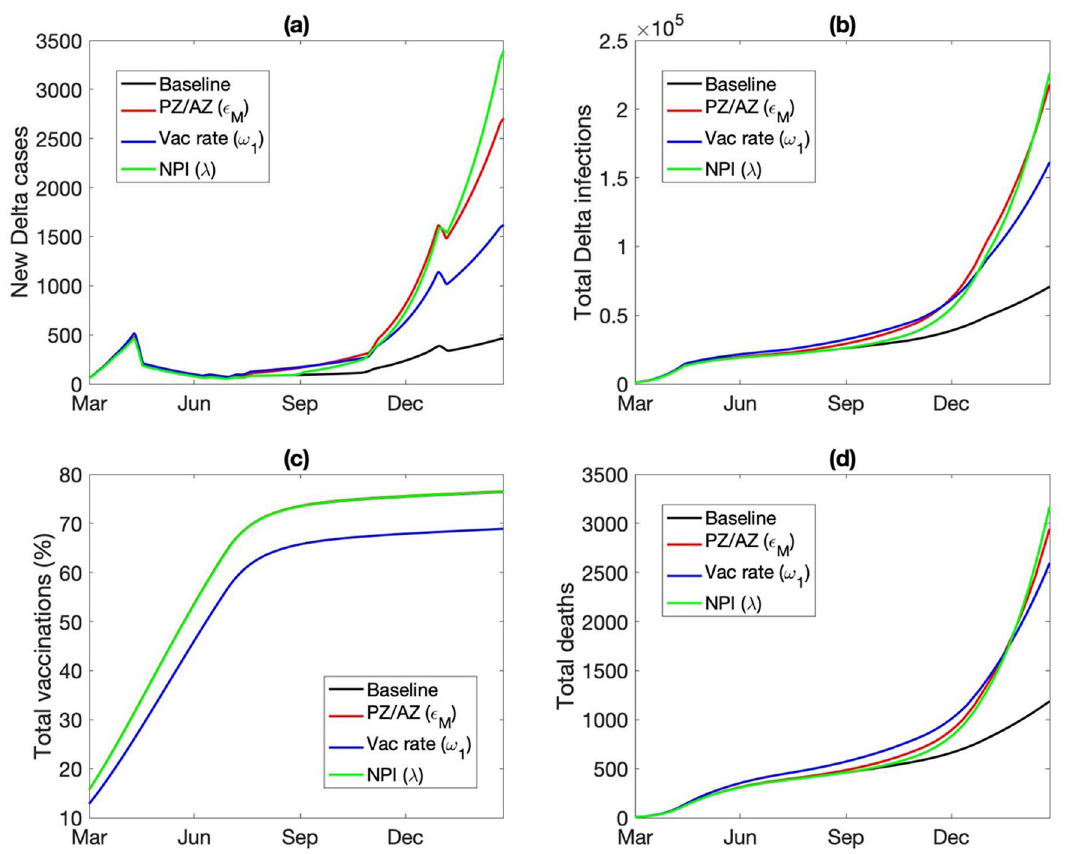
Figure 7. Predicted spread of the Delta variant, from March 2021 to March 2022, obtained for baseline parameters and three alternative scenarios. “PZ/AZ,” lower fraction of vaccines being Pfizer (from 95 to 40%), with the reduction made up with AstraZeneca, which offers reduced protection from Delta infections and a longer dosing delay. “Vac rate,” vaccination rate reduced by 20%. “NPI”, less stringent lockdown measured, with mobility increased by 25%. Among these scenarios considered, Delta outbreak is the most severe when the majority of the vaccines are value; with 60% AstraZeneca vaccines, 4.6 times; fewer restrictions (λ = 0.5 instead of 0.4), 5 times. See Fig. 10b. Similar trends are predicted for the vaccinated individuals infected by Neos (Fig. 10c), and for the total deaths